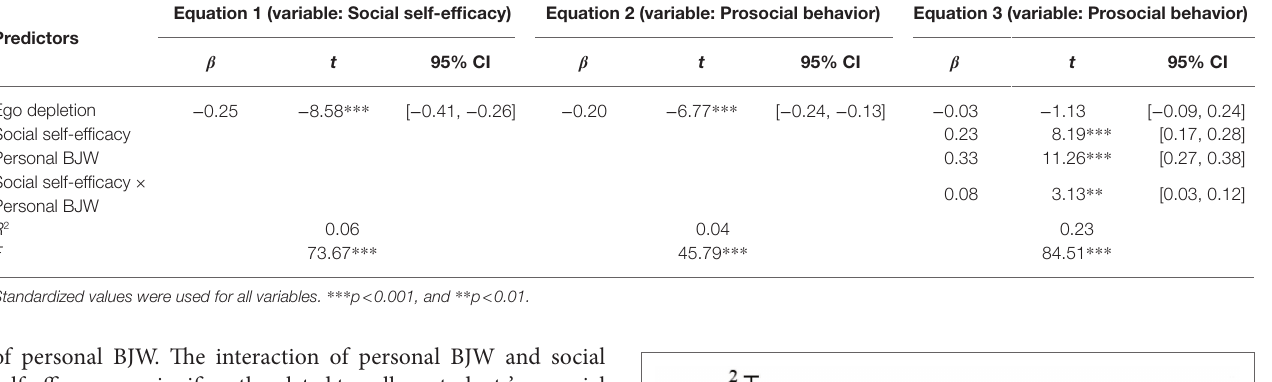
TABLE 3 | The moderating effect of personal BJW between social self-efficacy and prosocial behavior. Equation 1 (variable: Social self-efficacy) Equation 2 (variable: Prosocial behavior) Predictors